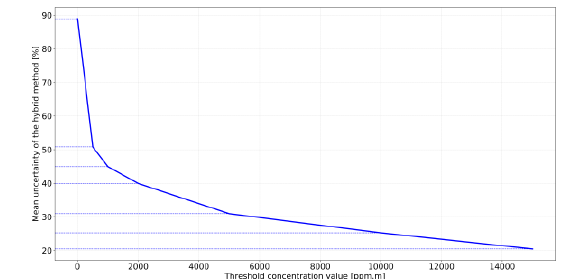
Figure 14 . Uncertainty of the hybrid method for the real data as a function of the threshold concentration value use to calculate the mean uncertainty, in